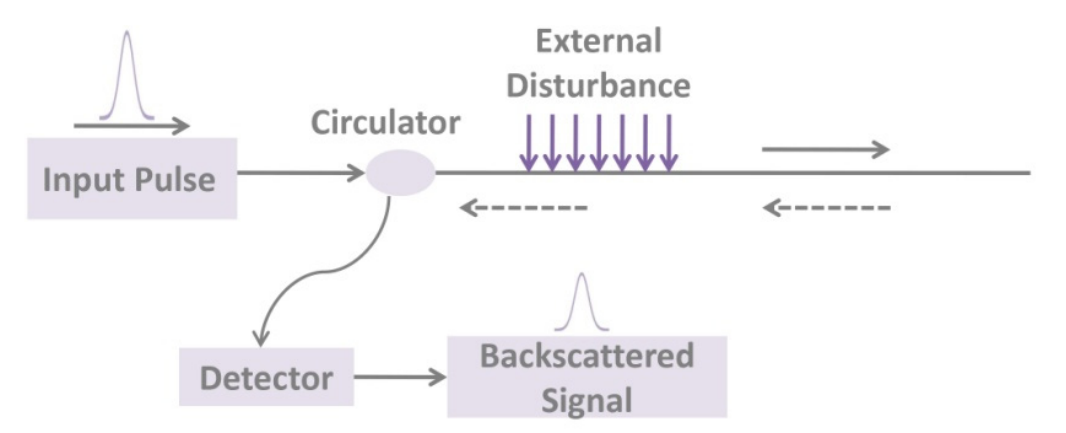
Figure 3. The principle of optical time-domain reflectometer (OTDR) based on backscattering.